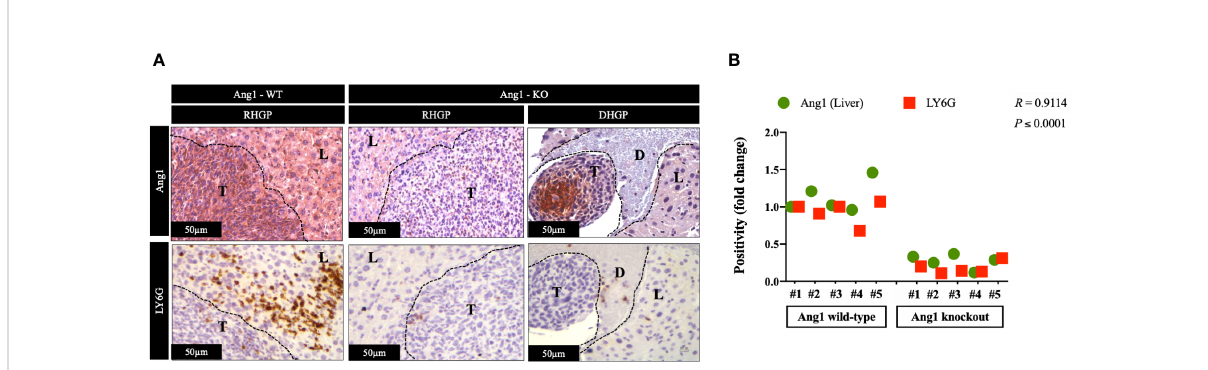
FIGURE 4 The expression of Ang1 in the host liver positively correlated with neutrophil in fi ltration. (A) Represents immunohistochemical staining of CRCLM sections generated by injecting MC38 cancer cells into wild-type (n=5) and Ang1 knockout (n=5) C57BL/6 mice. We used anti-Ang1 and anti- LY6G (neutrophil biomarker) antibodies. (B) Pearson correlation analysis con fi rmed the correlation between Ang1 expression and LY6G expression in CRCLM sections. Relative expression levels of Ang1 or LY6G were calculated by dividing the positivity value of each specimen from Ang1-wild type (Ang1-WT) and Ang1-kncokout (Ang1-KO) groups by the positivity value of specimen #1 from Ang1-WT group and then presenting the result as a fold